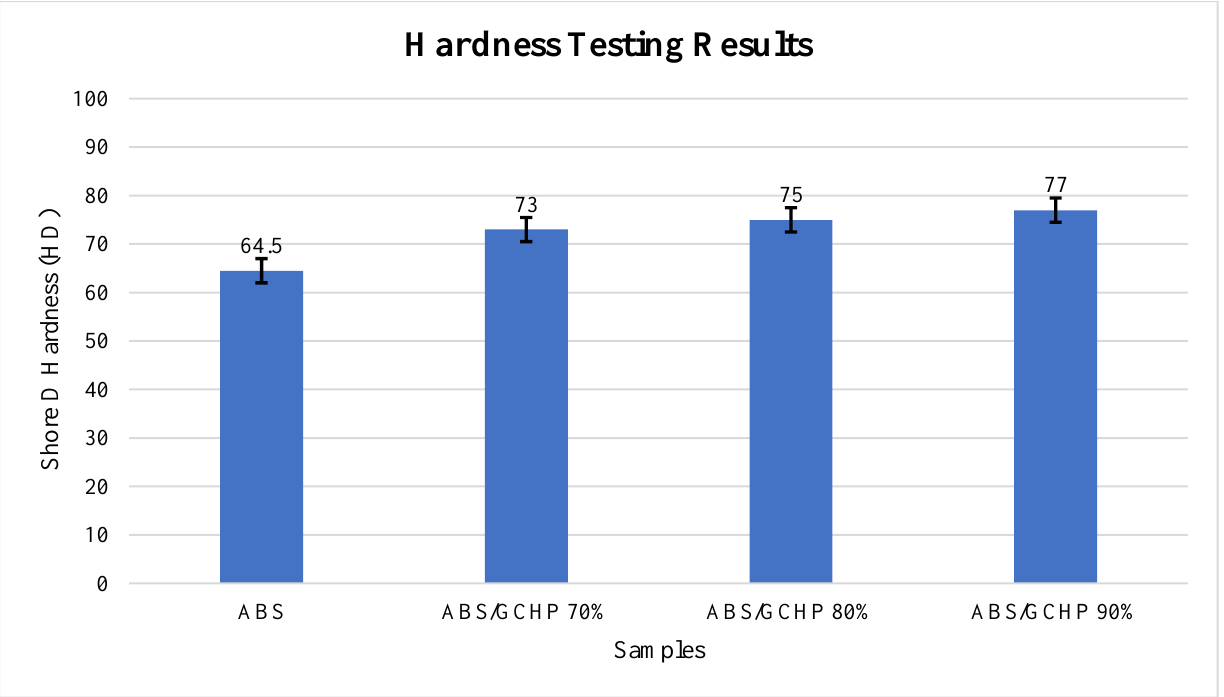
Figure 20. Hardness testing results for ABS/GCHP composites with ABS. The hardness value increased when the TA material was layer added closer to the surface [46]. A single layer of HCE added at 70% to ABS/HCE showed 72 HD with an 11.6% increase to its hardness value and ABS/HCE 80% showed a slight increase (15.50%) of 74.5 HD compared to ABS. ABS/HCE 90% composites showed a hardness value of 76 HD with an increase of 17.8% from ABS, as shown in Figure 21. Figure 22 shows the hardness results of ABS/GEP composites with ABS. A single layer of GEP with 0.2 wt.% GNPs added at 70% to ABS showed 75 HD, an increase of 16.28% compared to ABS. ABS/0.2 80% showed slight increase of 77 HD. ABS/0.2 GEP 90% composites showed a hardness value of 79 HD with an increase of 22.4% from ABS, as shown in Figure 22a. A single layer of GEP (0.4 wt.% GNPs) added at 70% to ABS showed 79 HD, an increase of 22.4% compared to ABS. ABS/0.4 80% showed a slight in- crease of 80 HD. ABS/0.4 GEP 90% composites showed a hardness value of 81.5 HD with an increase of 26.36% from ABS, as shown in Figure 22b. Similarly, a single layer of GEP (0.6 wt.% GNPs) added at 70% to ABS showed 80 HD, an increase of 24% compared to ABS. ABS/0.6 80% showed a hardness value of 82 HD, and the highest hardness value of 84 HD was observed for ABS/0.6 GEP composite when a TA material layer was added at 90% completion. This is an increase of 30.23% when compared to FFF-manufactured ABS, as shown in Figure